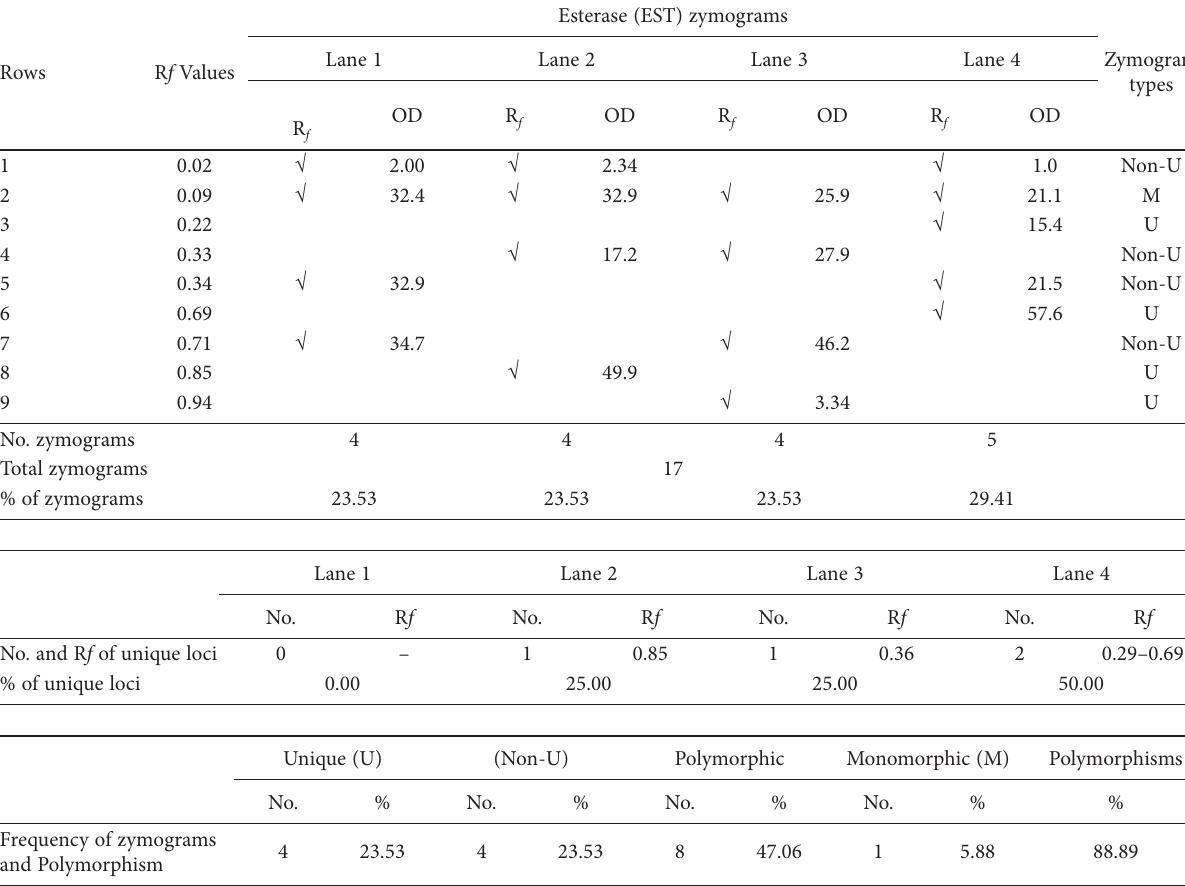
Table 5. Distribution of catalase (CAT) zymograms of EMF non-exposed and exposed Zea mays seedlings for days of exposure times (Ex-0, Ex-1, Ex-3, and Ex-5) based on relative front (R f ) Values and optical densities (OD). Lanes 1–4 represented the days of exposure times (Ex- 0, Ex- 1, Ex-3, and Ex-5), respectively.